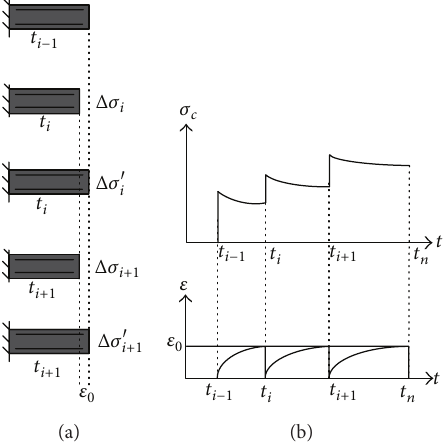
Figure 4: Evolution of (a) deformation and (b) concrete stress of reinforced concrete.